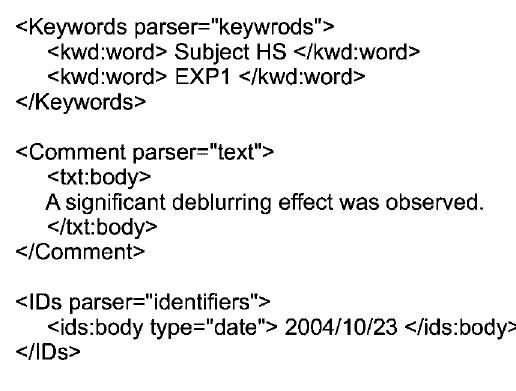
Figure 2. A dialog window for editing the metadata of a stored resource . The required metadata are title, keywords, comment, and identifications. By clicking the “Open” button, users can open the resource file using an appropriate application.